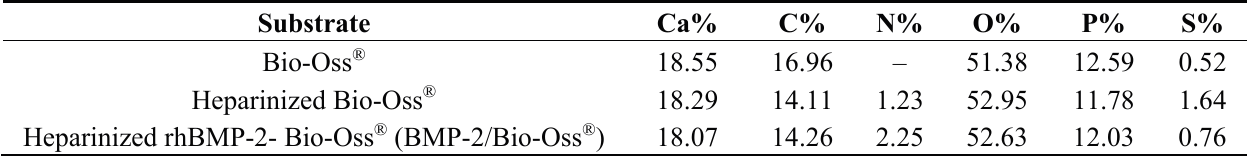
Figure 3. X-ray photoelectron spectroscopy wide-scan spectra of (a) Bio-Oss ® ; (b) heparinized Bio-Oss ® ; and (c) heparinized rhBMP-2-Bio-Oss ® . Table 1. Surface elemental compositions of Bio-Oss ® , heparinized Bio-Oss ® , and heparinized rhBMP-2-Bio-Oss ®